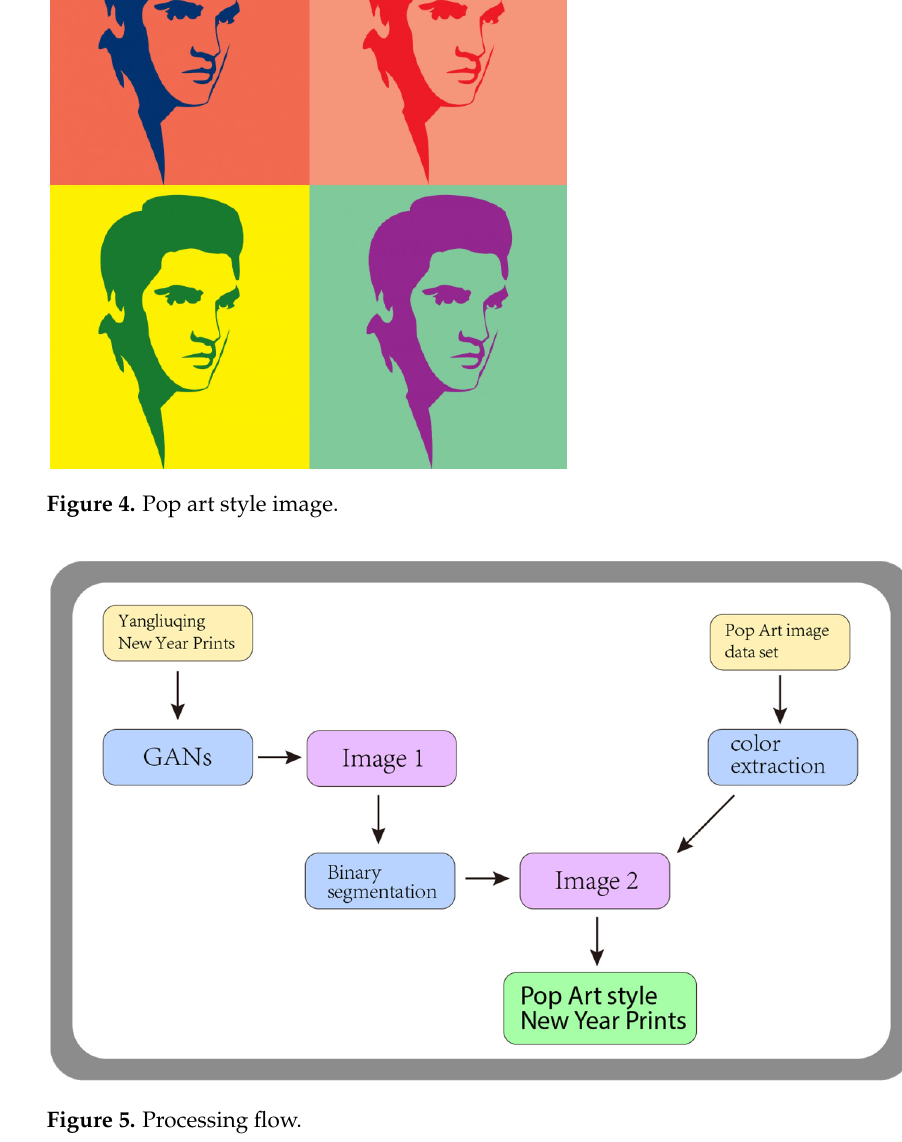
Figure 5. Processing